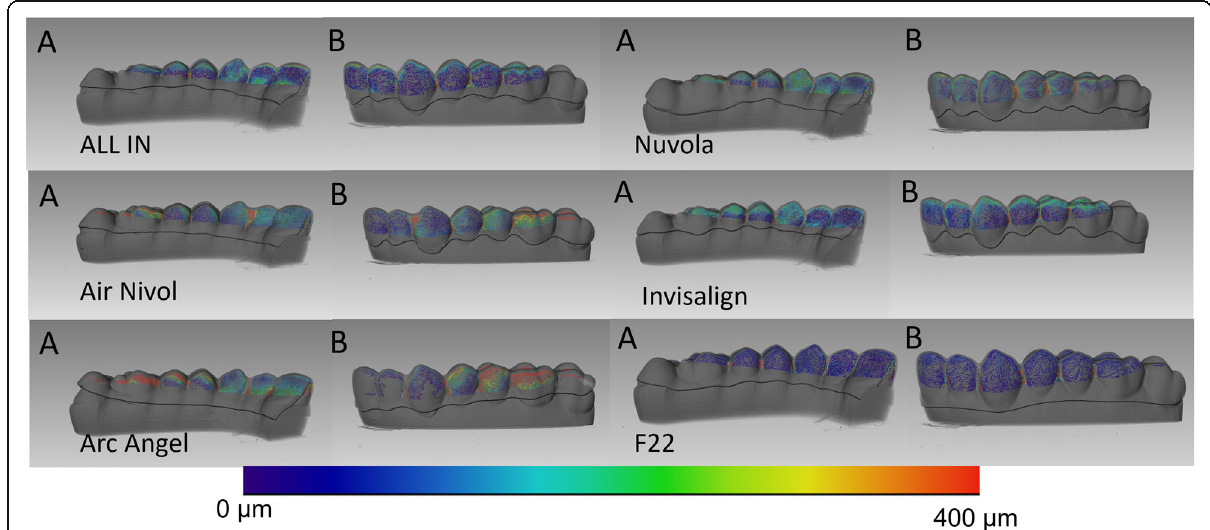
Fig. 5 Representative colourimetric skeleton with corresponding map of the distances measured for the six aligners from internal ( a ) and external ( b )